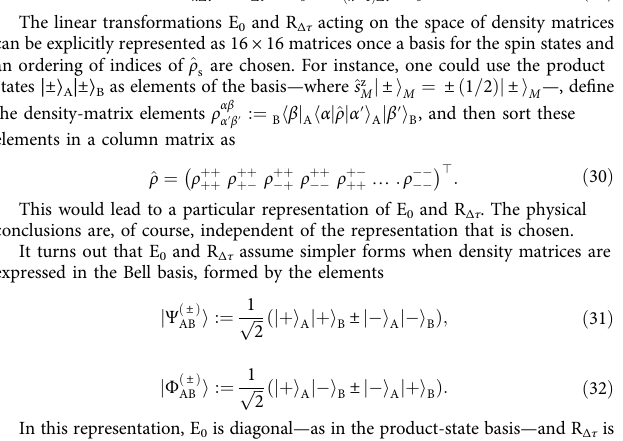
complex situation is currently under investigation.